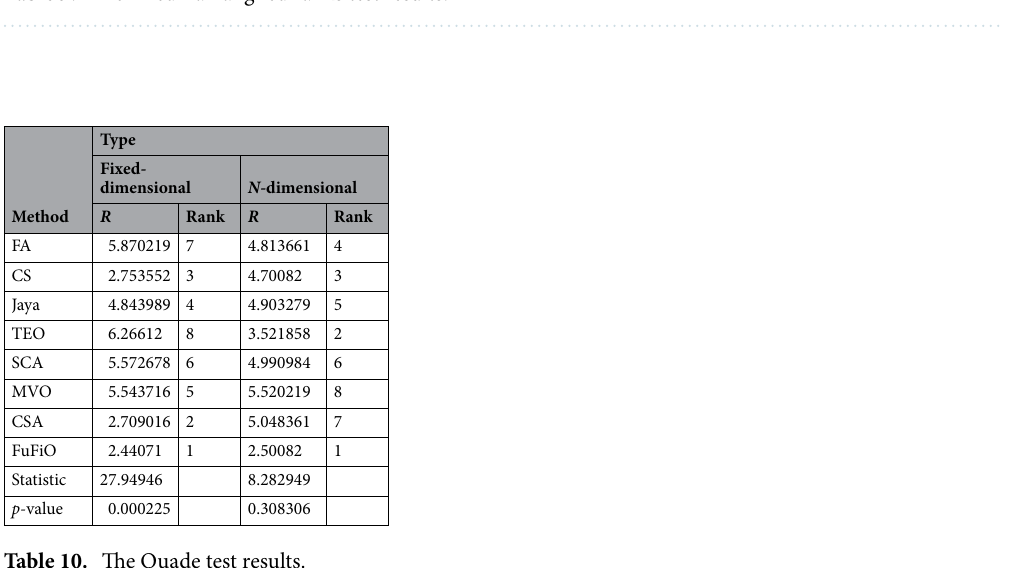
Table 10. The Quade test